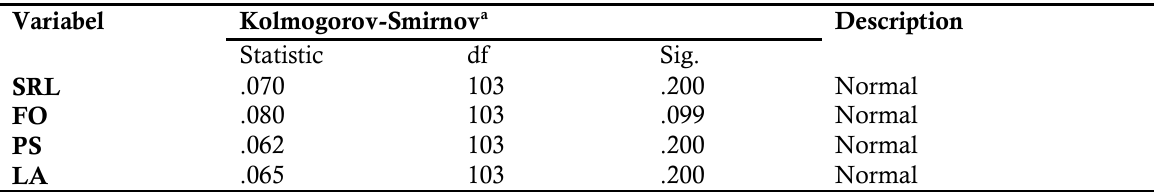
Table 4. The result of normality